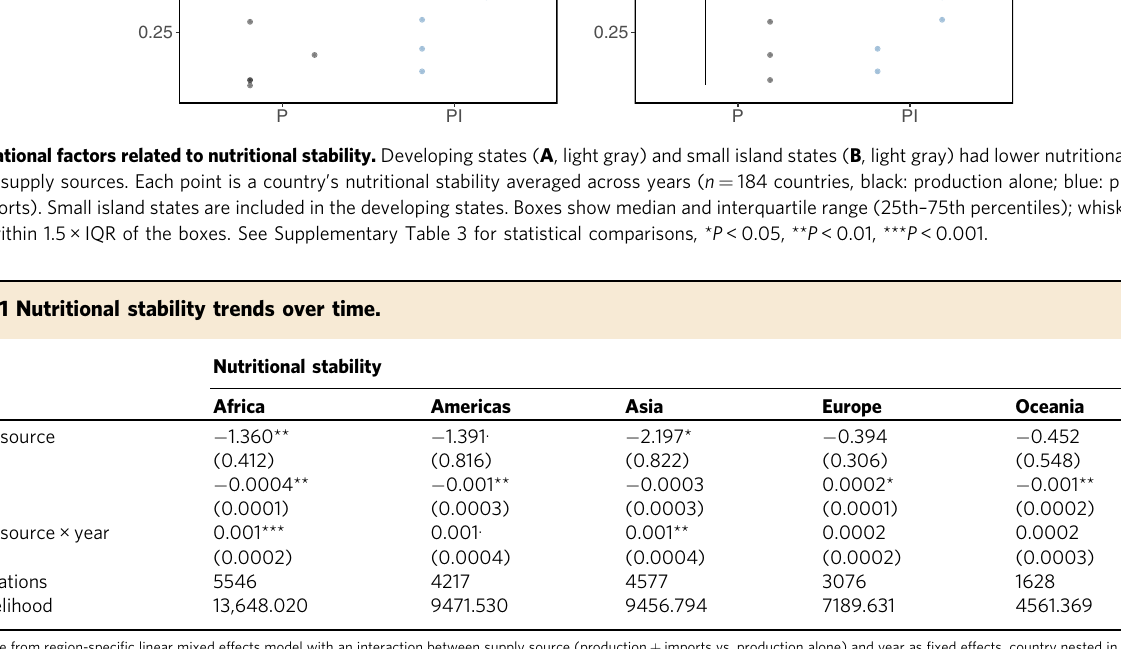
Results are from region-speci fi c linear mixed effects model with an interaction between supply source (production + imports vs. production alone) and year as fi xed effects, country nested in source as random effects, and an autoregressive correlation structure to account for temporal autocorrelation. Values are model coef fi cients with standard error in parentheses. * P <0.05; ** P <0.01; *** P